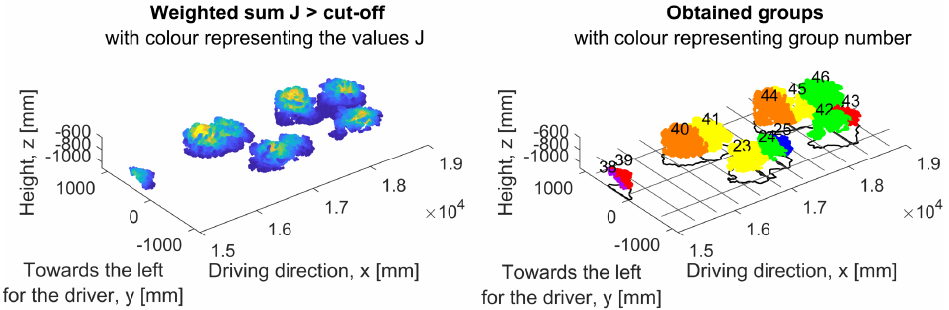
Figure 4. The cabbage strip shown in Figure 2 after merging the two point clouds, and subsequently calculating the weighted sum, to categorize each point as either soil or plant. On the left, all plant points of the central two rows of this strip. On the right the result of two-step grouping as described in Section 2.5. Note that for example, cluster 40 and 41 have been identified satisfactory, while for example, the points in cluster 45 should actually be subscribed to both of the adjacent clusters.